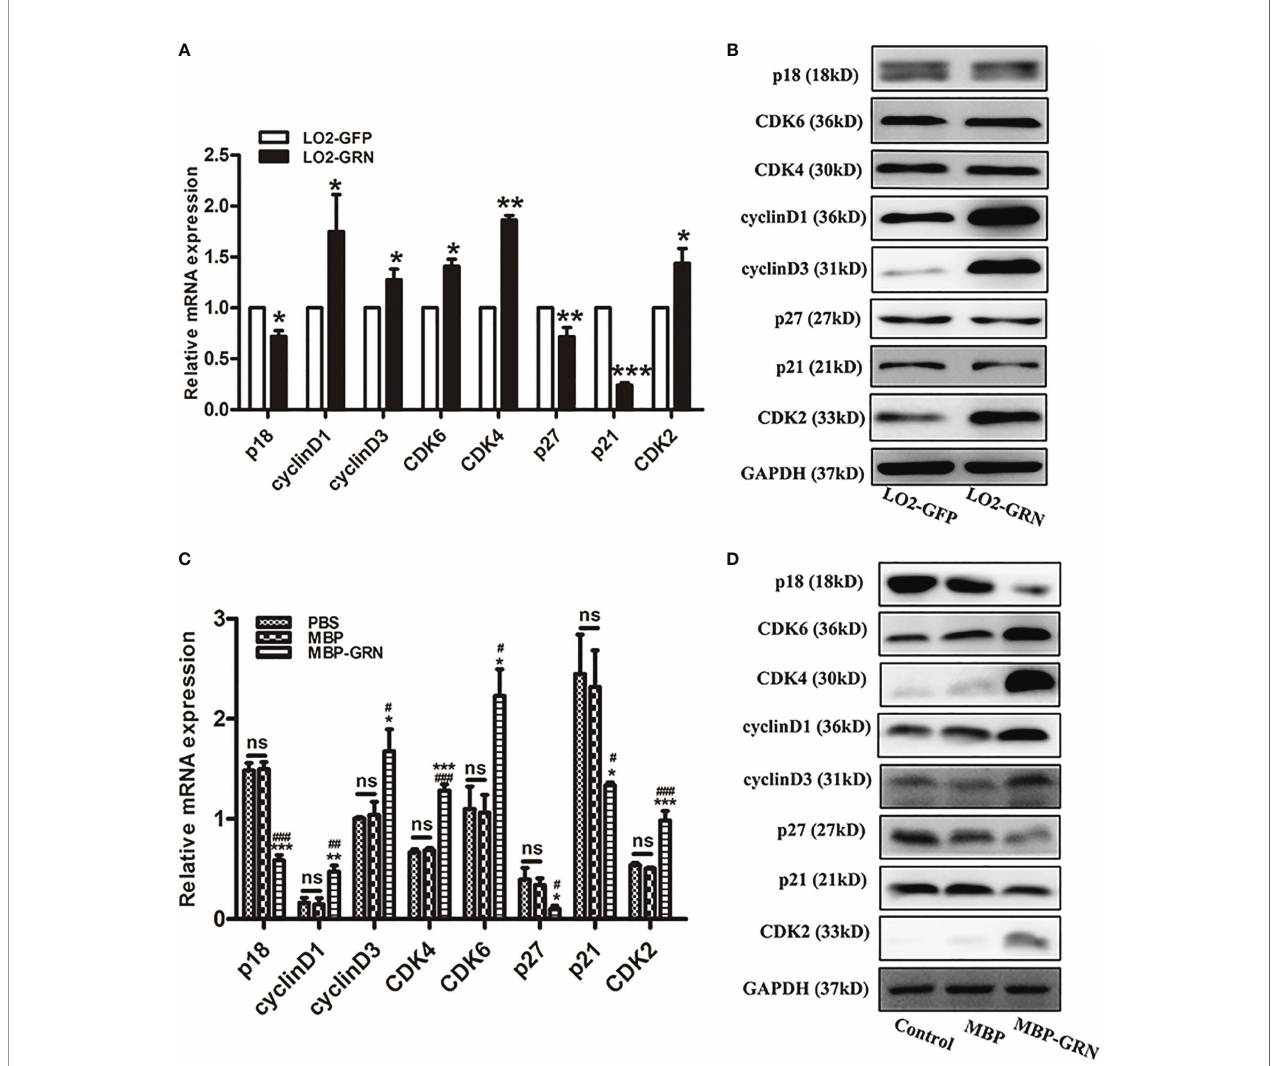
FIGURE 3 | Effects of Cs GRN overexpression on the regulation of cell-cycle-related genes expression. (A, B) The mRNA and protein expression of p18, CyclinD1, CyclinD3, CDK6, CDK4, P27, P21, and CDK2 were detected in Cs GRN-overexpressed LO2 cells. * P < 0.05 versus control group, ** P < 0.01 versus control group, *** P < 0.001 versus control group. (C, D) The mRNA and protein expression of cell-cycle-related genes were detected in recombinant Cs GRN protein – treated LO2 cells. * P < 0.05 versus PBS group, ** P < 0.01 versus PBS group, *** P <0.001 versus PBS group. # P < 0.05 versus MBP group, ## P < 0.01 versus MBP group, ### P < 0.001 versus MBP group. The relative mRNA levels of the target genes were determined by q-PCR. The protein expression was determined by Western blot, and the quanti fi cation of protein expression was measured by Image J software. Three independent experiments were conducted. NS means NO statistic